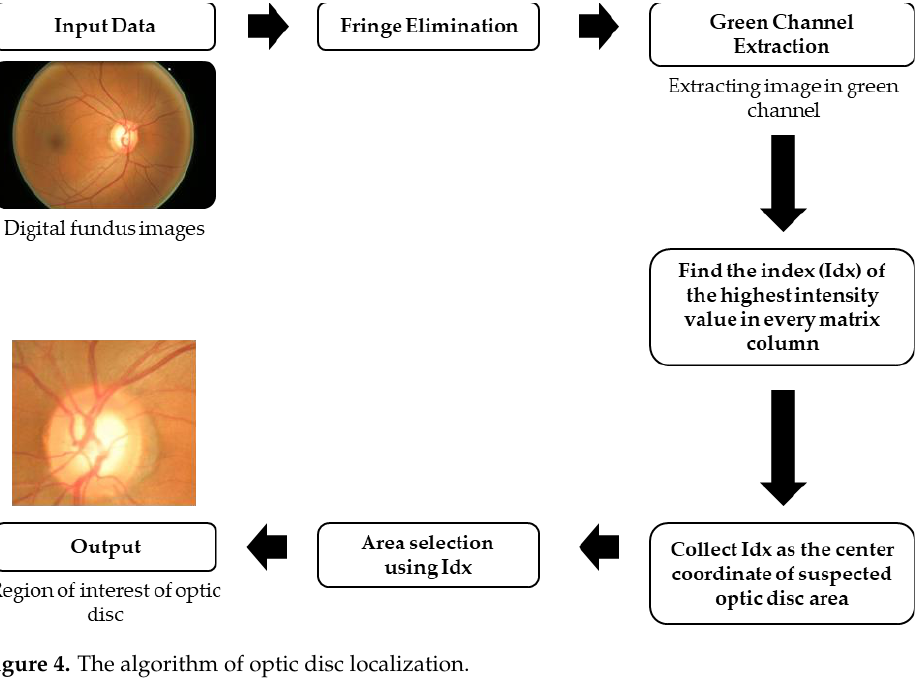
Figure 4. The algorithm of optic disc localization.